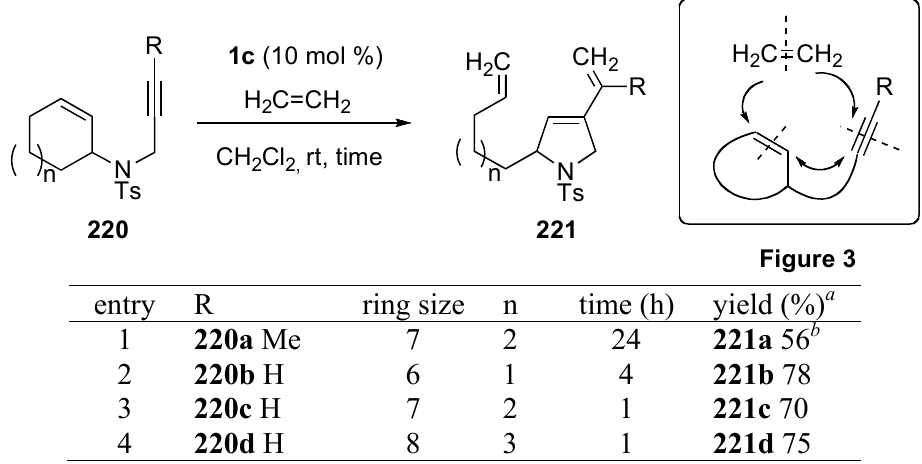
Table 2. ROM-RCM of